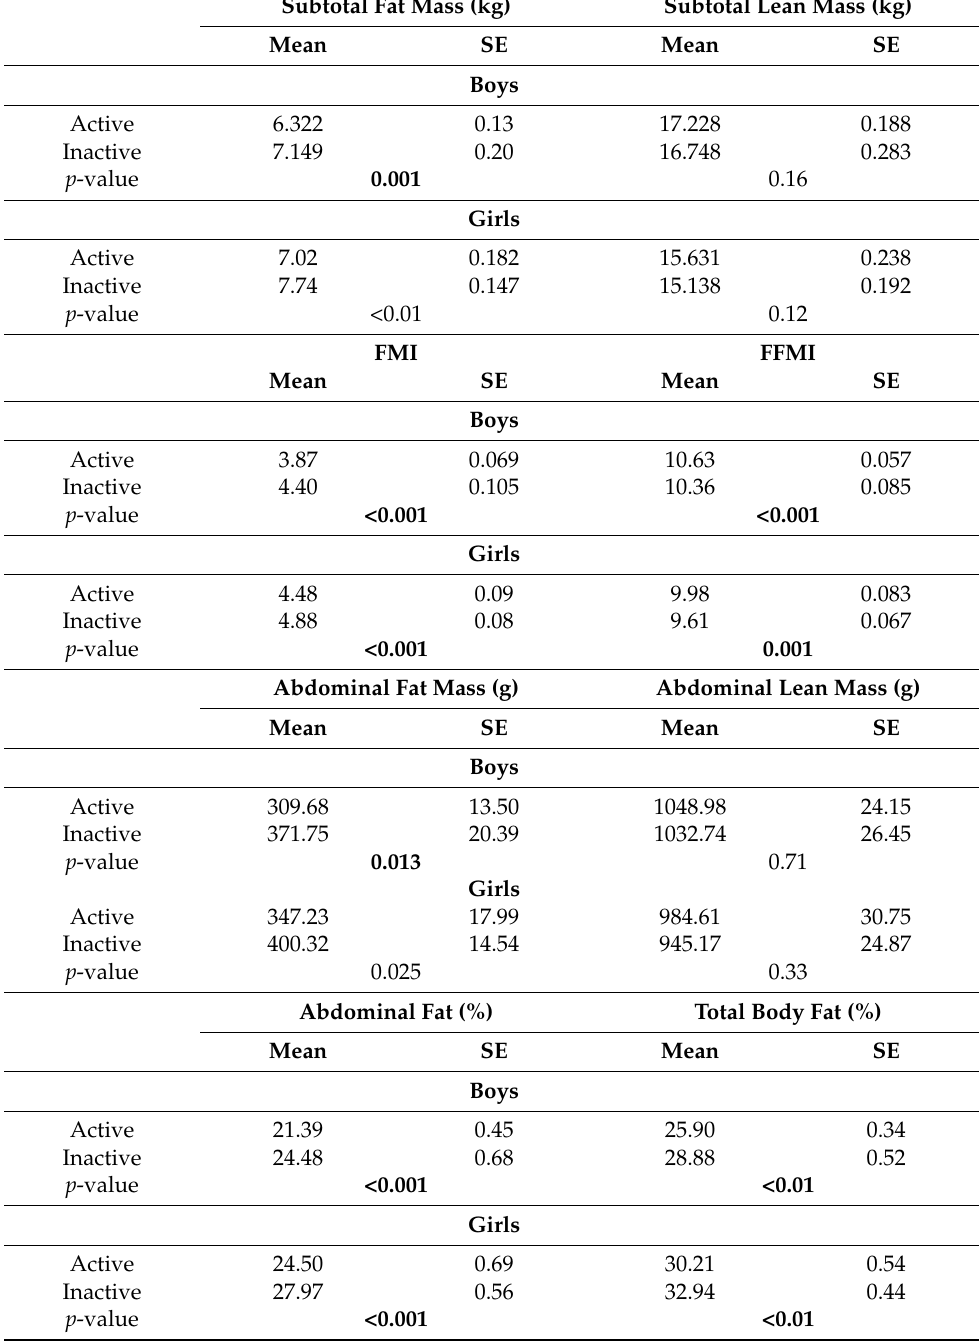
Table 2. Adjusted means of body composition parameters between being active or not by sex. Data are adjusted by RWG, BMI of the parents, smoking during pregnancy, migrant origin of the mother, child BMI z-score at 7 years, DQI, and